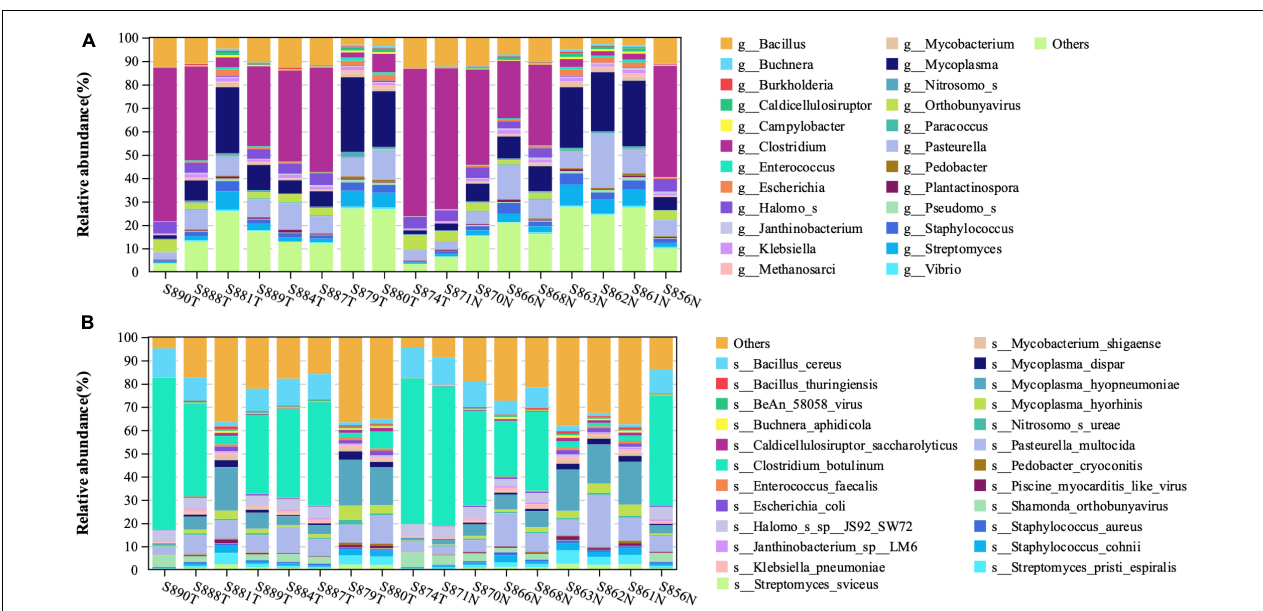
FIGURE 1 | The structural characteristics of the endometrial microbiota. Taxonomic classification of the endometrial microbiota of the EC and normal group at the level of genus (A) and species (B) .